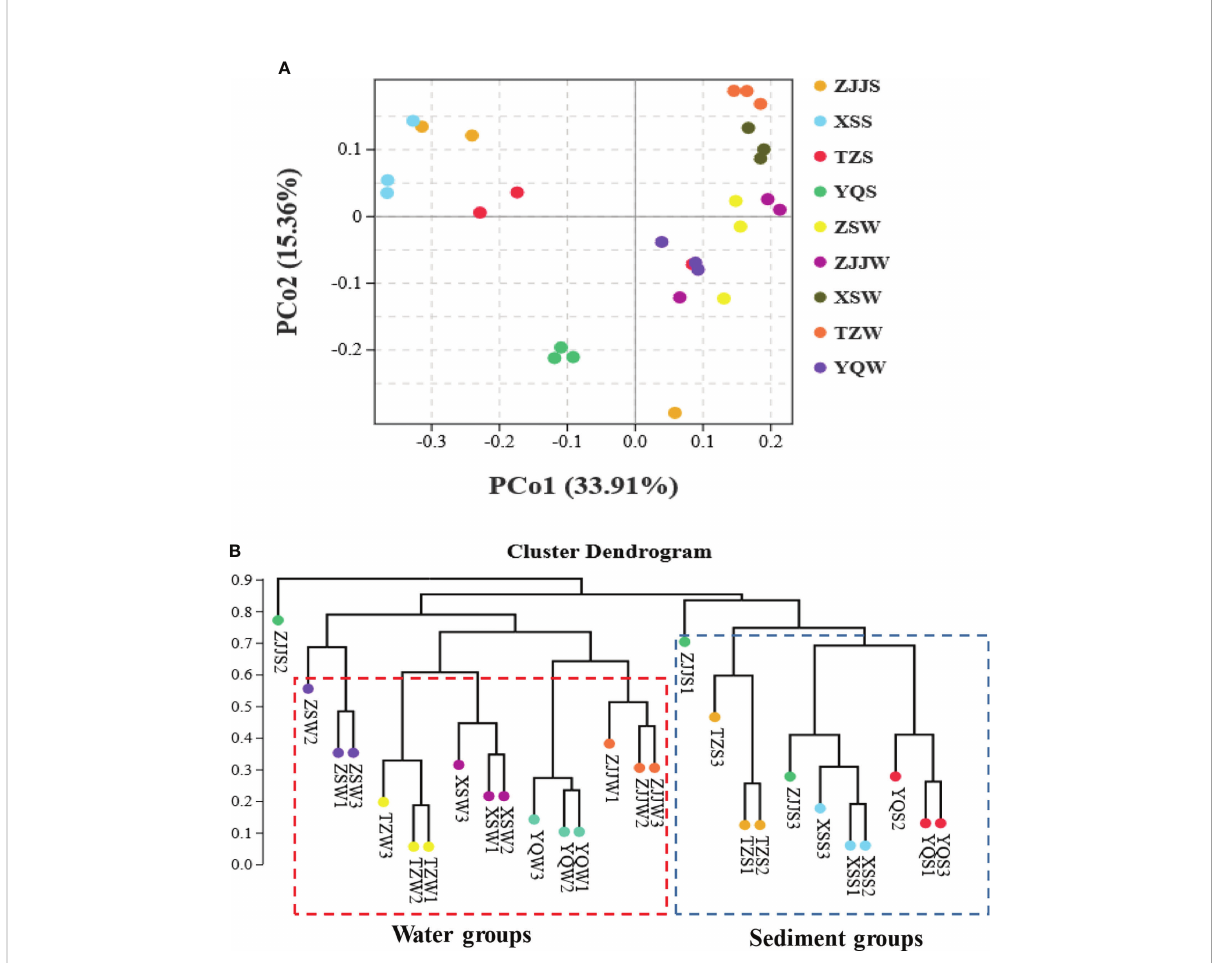
FIGURE 5 The bacterial community structural differences among the seawater and sediment groups. (A) Principal component analysis (PCoA) based on a weighted UniFrac distance; (B) UPGMA analysis based on a bray-curtis